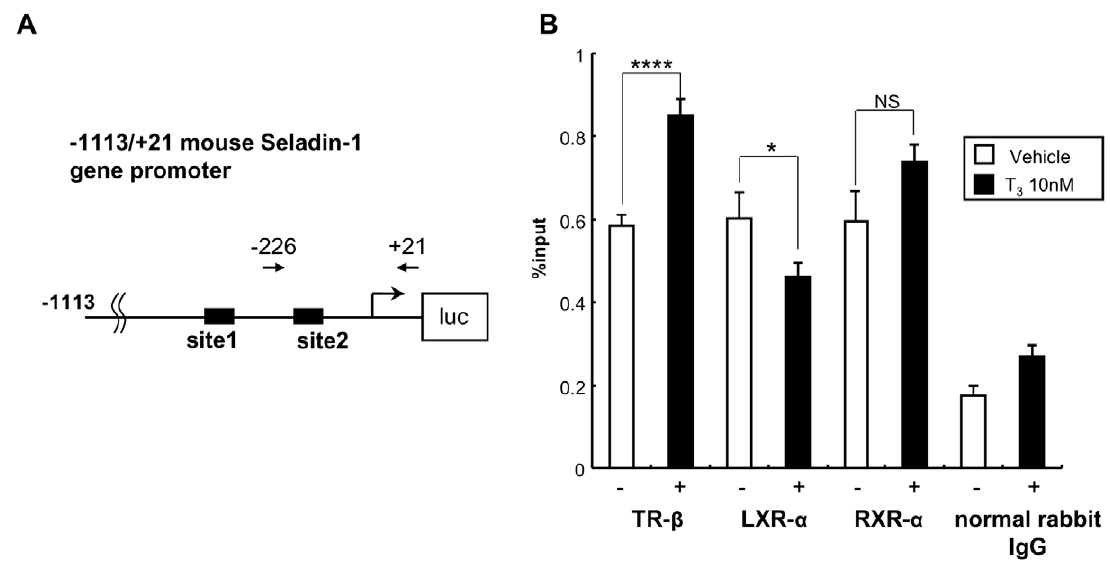
Figure 8. TR- b is recruited to the site 2 region in the mouse Seladin-1 gene promoter in a T 3 -dependent manner. The location of the PCR primers is indicated in an image above the data as arrows. The closed boxes indicate site 1 and 2 (A). Real-time PCR was performed to determine the relative value of the enrichment of each nuclear receptor. The value is shown as % of input (mean 6 S.E., n=8) (B). TR- b , RXR- a and LXR- a are recruited to the region from 2 226 bp to + 21 bp. The recruitment of TR- b and RXR- a is increased upon T 3 administration. The normal rabbit IgG was used as a negative control. An asterisk indicates that the difference between the denoted pairs is significant at a confidence level of p , 0.05(*) and p , 0.0001(****). NS: not significant.